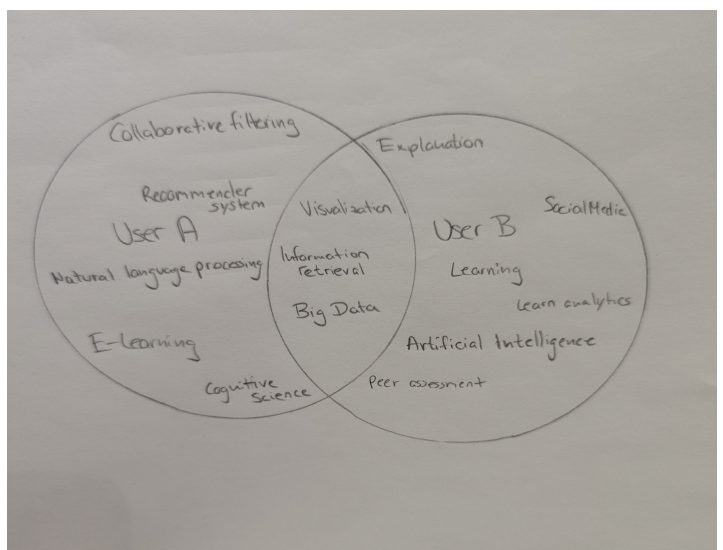
Figure 10. Dashboard starting page.